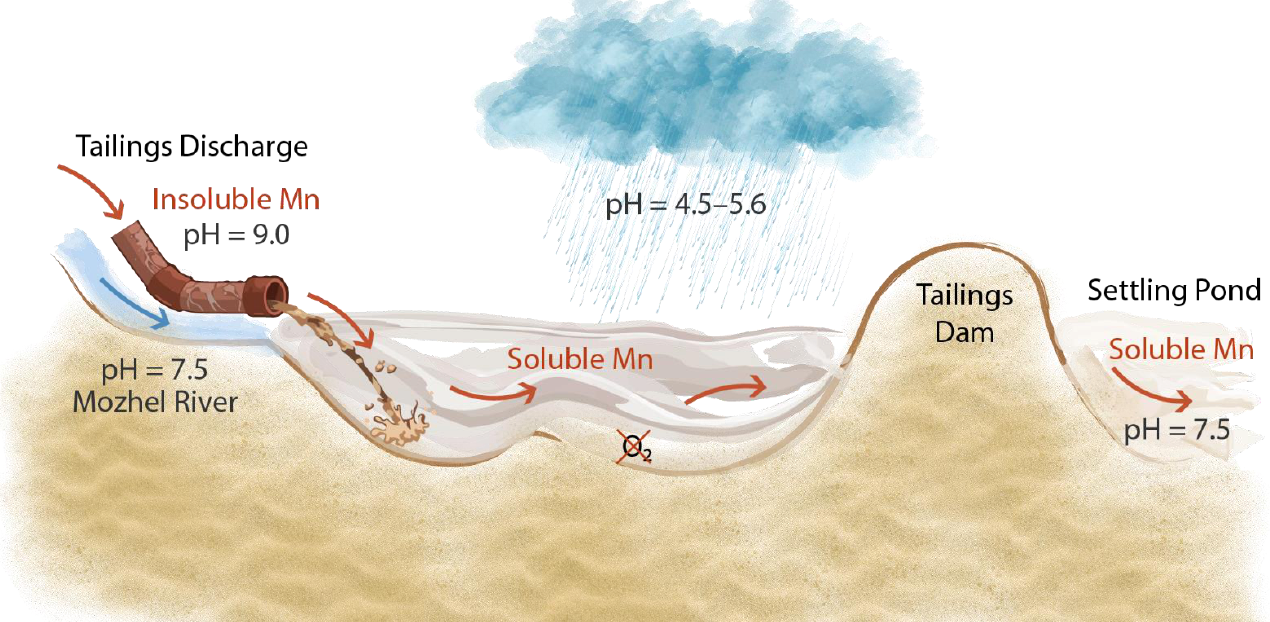
Figure 5. Migration of Mn compounds from the processing plant at the baddeleyite-apatite-magnetite deposit as a mixture component in the pulp discharged into the tailings storage facility with the further shift into the soluble state under the changing redox and acidity water parameters.